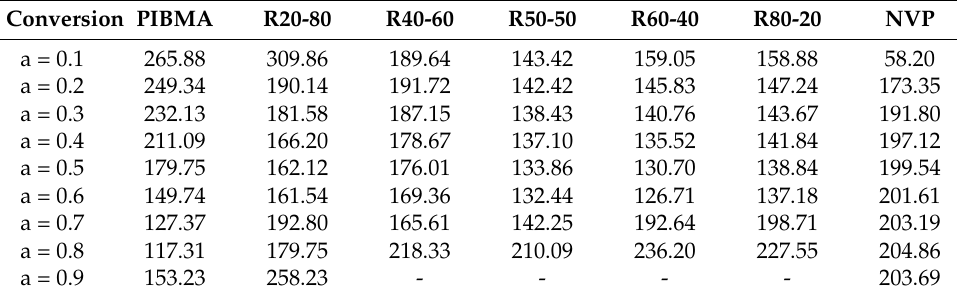
Table 8. Activation energies Ea (KJ/mol) by the OFW